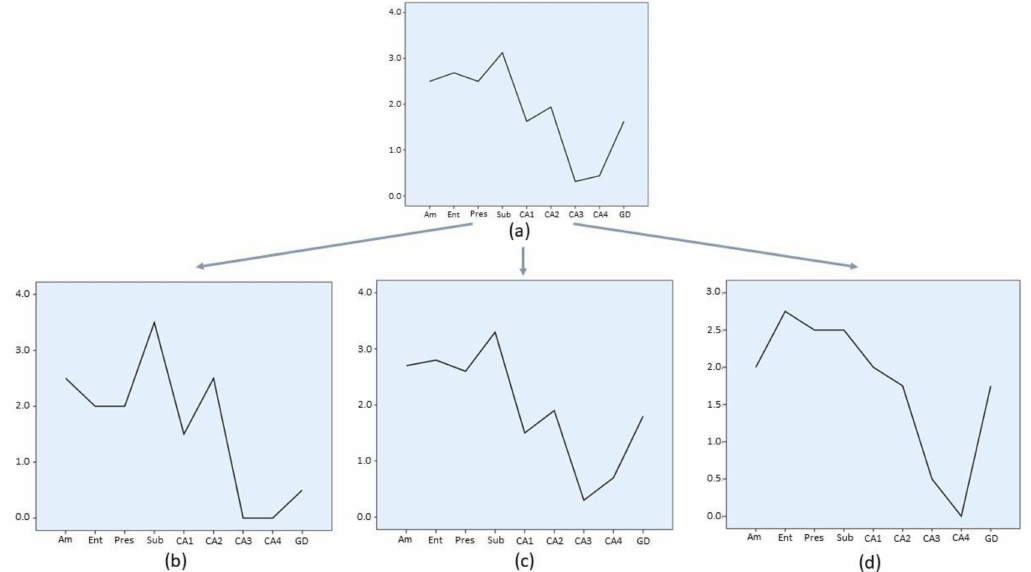
Figure 5. Regional profile of average involvement (Ai) intensity along the medial temporal lobe in sCJD. Range of phenotypic diversity within the sCJD MV2K histotype. Note the different scale range of single charts. ( a ) All sCJD MV2K cases, either pure or mixed type, as shown in Figure 3c; ( b ) pure sCJD MV2K cases; ( c ) cases with a sCJD MV2K+C phenotype; and ( d ) cases showing the sCJD MV2K+1 phenotype. Am : amygdala; Ent : entorhinal cortex; Pres : presubiculum; Sub : subiculum; CA1 , CA2 , CA3 and CA4 : CA Sommer’s sectors of the hippocampus; GD : dentate